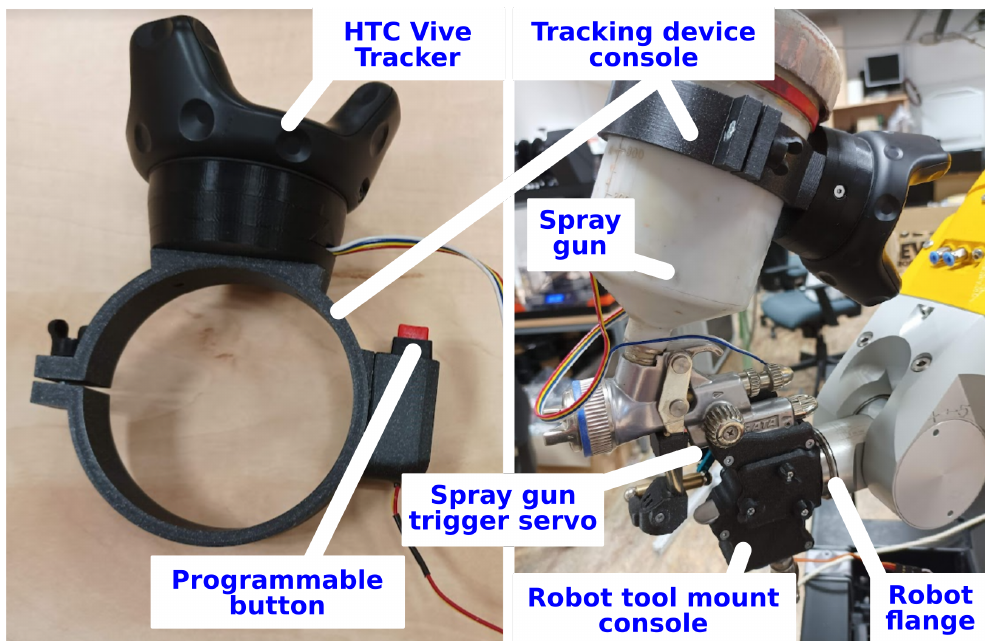
Figure 3. Tracking device console ( left ) with attached HTC Vive Tracker and programmable button, robot tool mount console ( right ) allowing installation of the tool to the robot flange for the automatic operation, here with the SATA jet 100 spray gun attached to a Fanuc